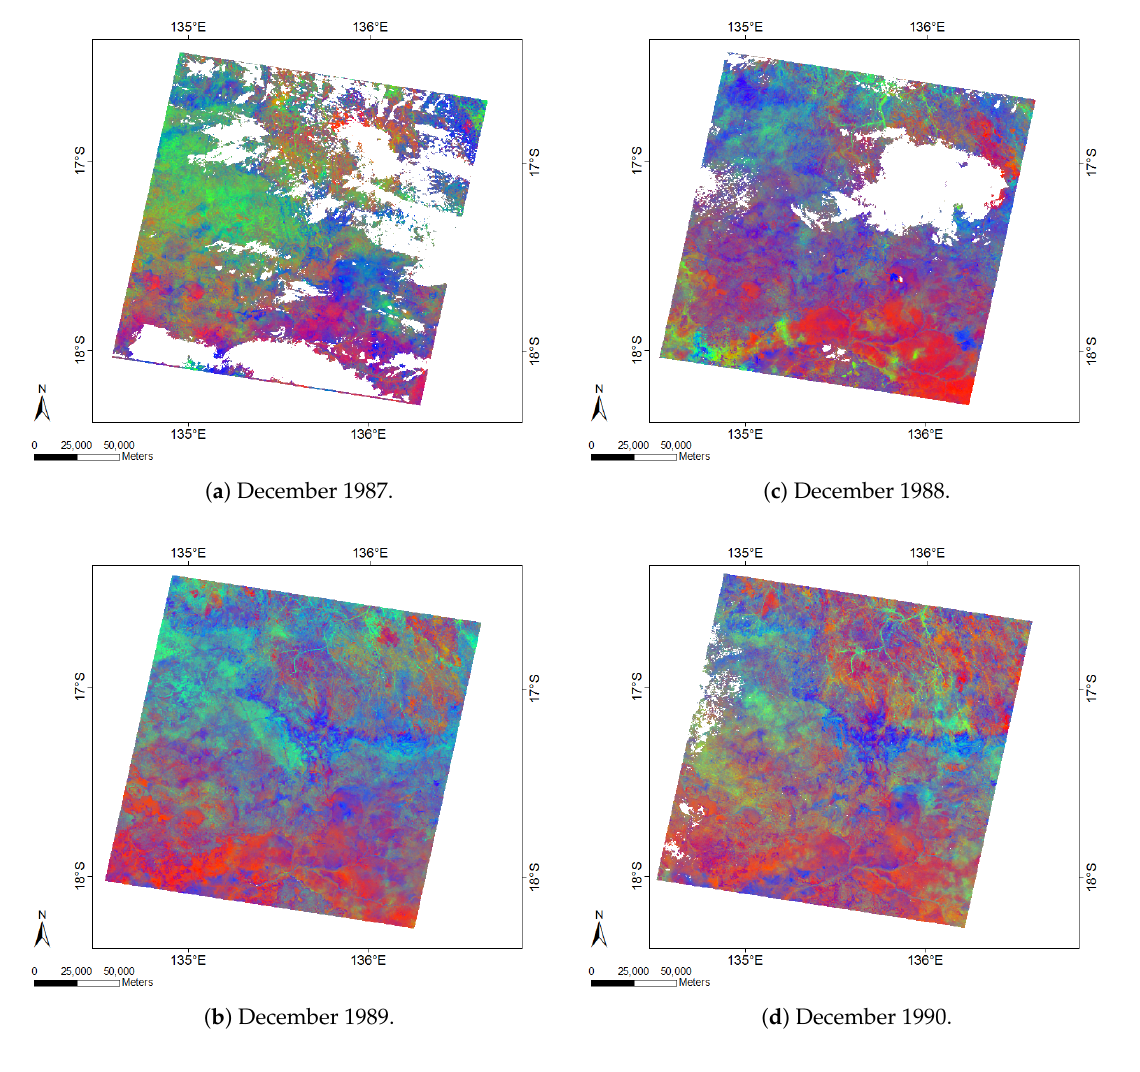
Figure 5. FCover of Landsat Thematic Mapper (Landsat 5) scenes of four years showing white data gaps caused by masking out clouds and clouds